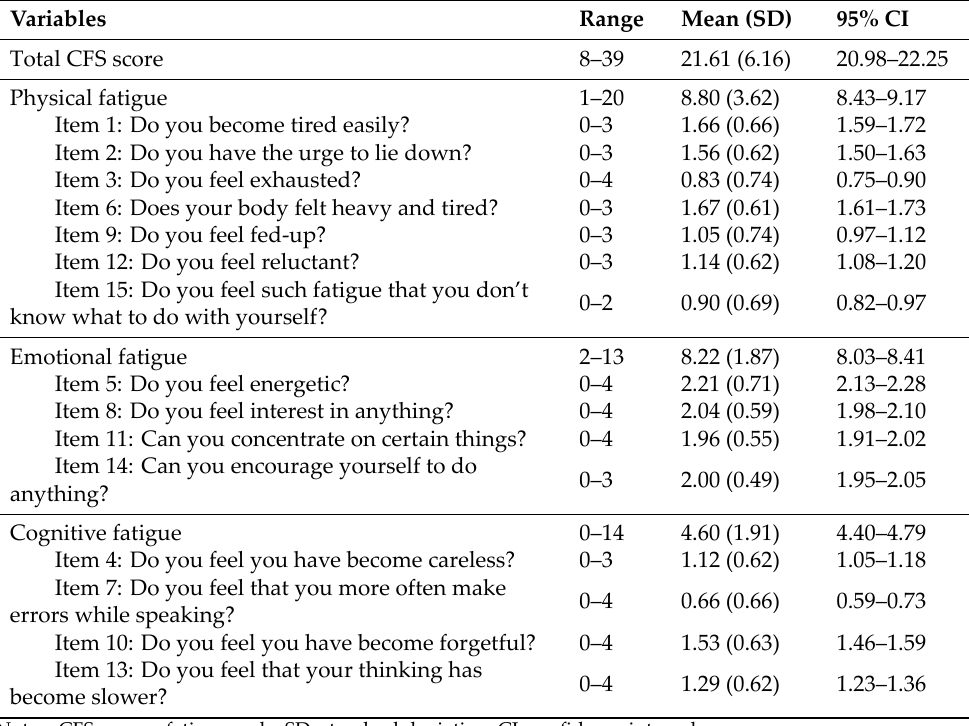
Table 2. CFS scores in patients with colorectal cancer ( n =